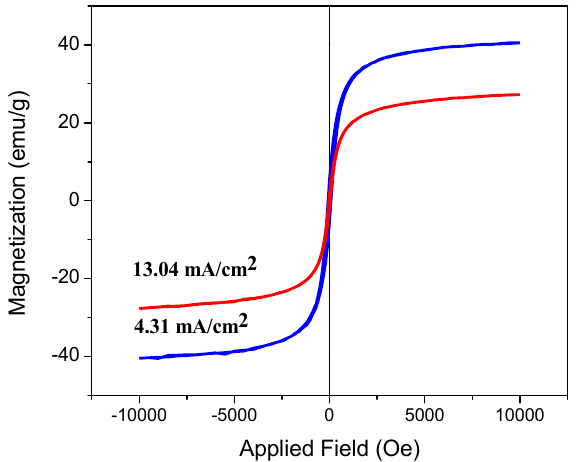
Fig. 3. Magnetization curve graph of 1 and 3 samples , magnetite nanoparticles produced by electrochemical method in current density and in presence of NaOH